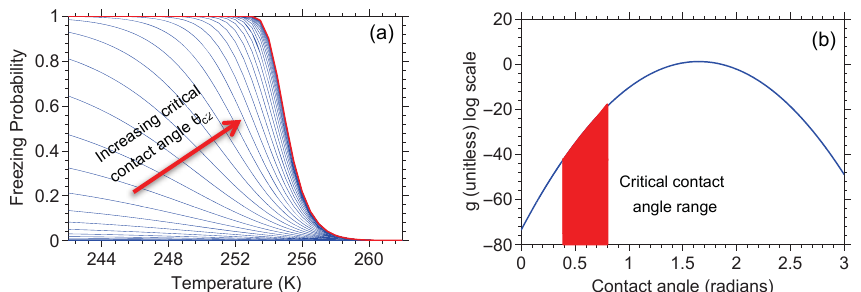
Figure 3. (a) Identifying the critical contact angle range. The thin blue curves are retrieved from application of the simplified Eq. (10), which approximates the freezing probability by integrating over a smaller contact angle range, [ θ c application of the complete Eq. (7), which integrates over the full contact angle range. Both approaches use the same g distribution retrieved for the case example in Sect. 3.1 with µ = 1 . 65 and σ = 0 . 135. (b) The g distribution from the case example in Sect. 3.1 is plotted in log scale and shows the critical contact angle range retrieved in Sect. 3.2 (θ c